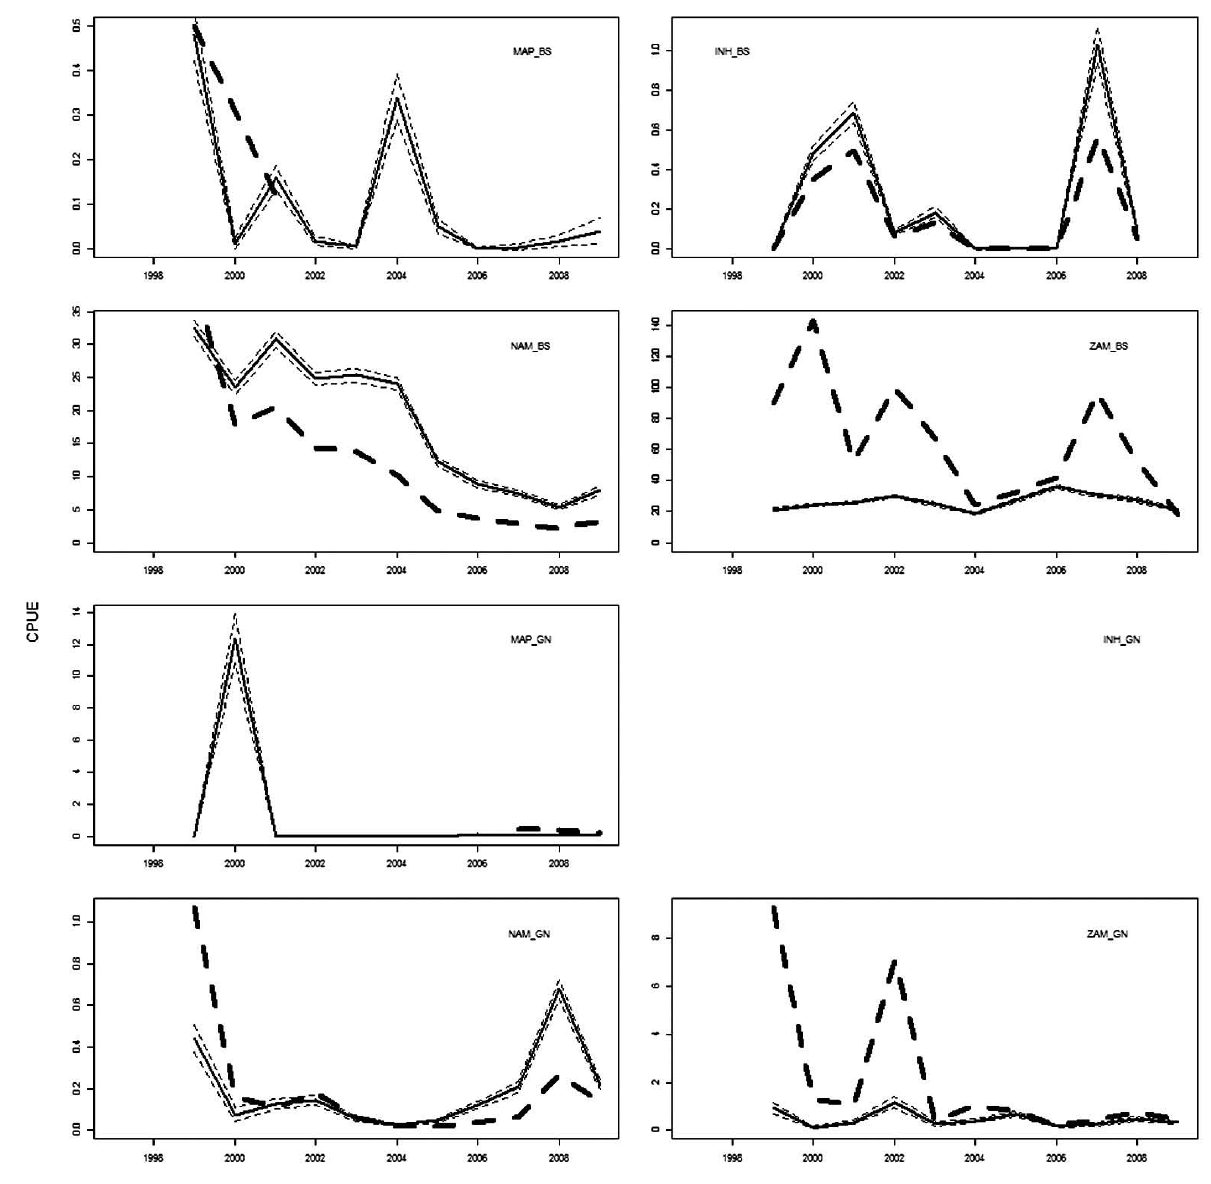
Fig. 6. – Yearly average (kg day –1 , continuous line) and CPUENET [kg day –1 (m of nets) –1 , dashed line] of Tryssa vitrirostris with the 95% confidence intervals as estimated by the GAMs for the provinces and gears analysed using final models (see Table 3 for details). CPUENET is multiplied per 100 for a straightforward representation, except for MAP_BS, which was multiplied per two. See Table 3 for species code and statistical